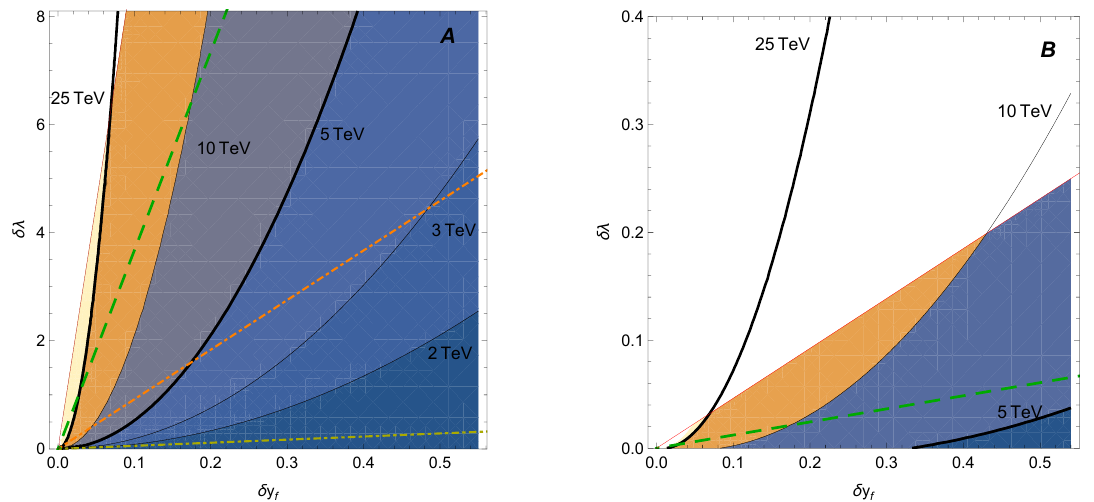
Figure 1 . Estimated (maximal) NP mass M max in dependence on the variation in the Yukawa cou- plings ( (cid:14)y f ) and in the triple-Higgs self coupling ( (cid:14)(cid:21) ) in Scenario A (left) and B (right). The colored lines denote NP couplings of g (cid:3) = 1 ; 4 ; 8 ; 4 (cid:25) , respectively (from yellow to red). See text for